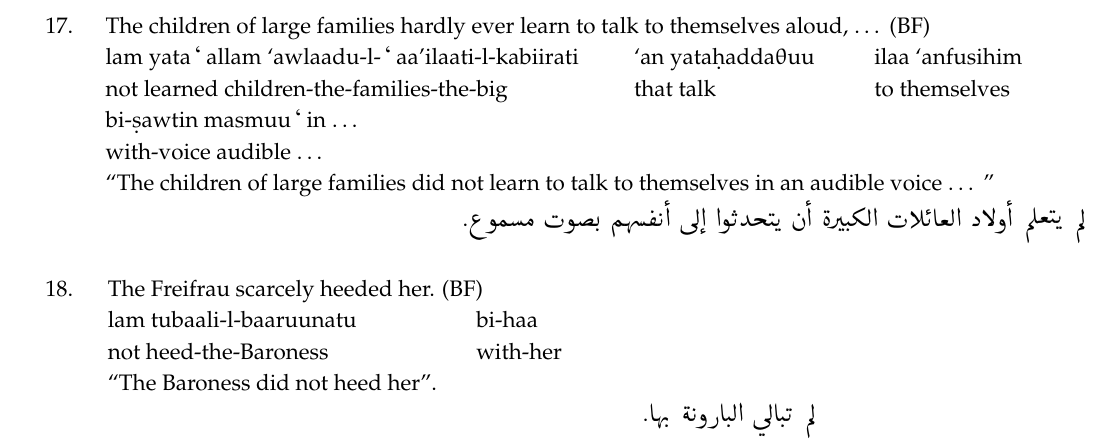
Table 4. Frequency and percentage of translation strategies in rendering -ly